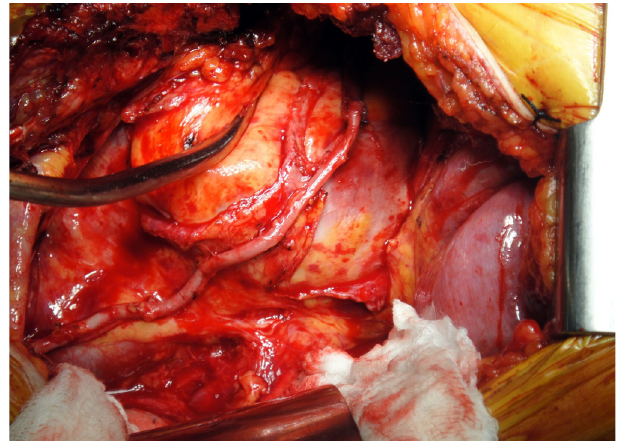
Fig.4 - Anastomosis performed - The anastomosis RITA-SVG-PDA is performed with an excellent